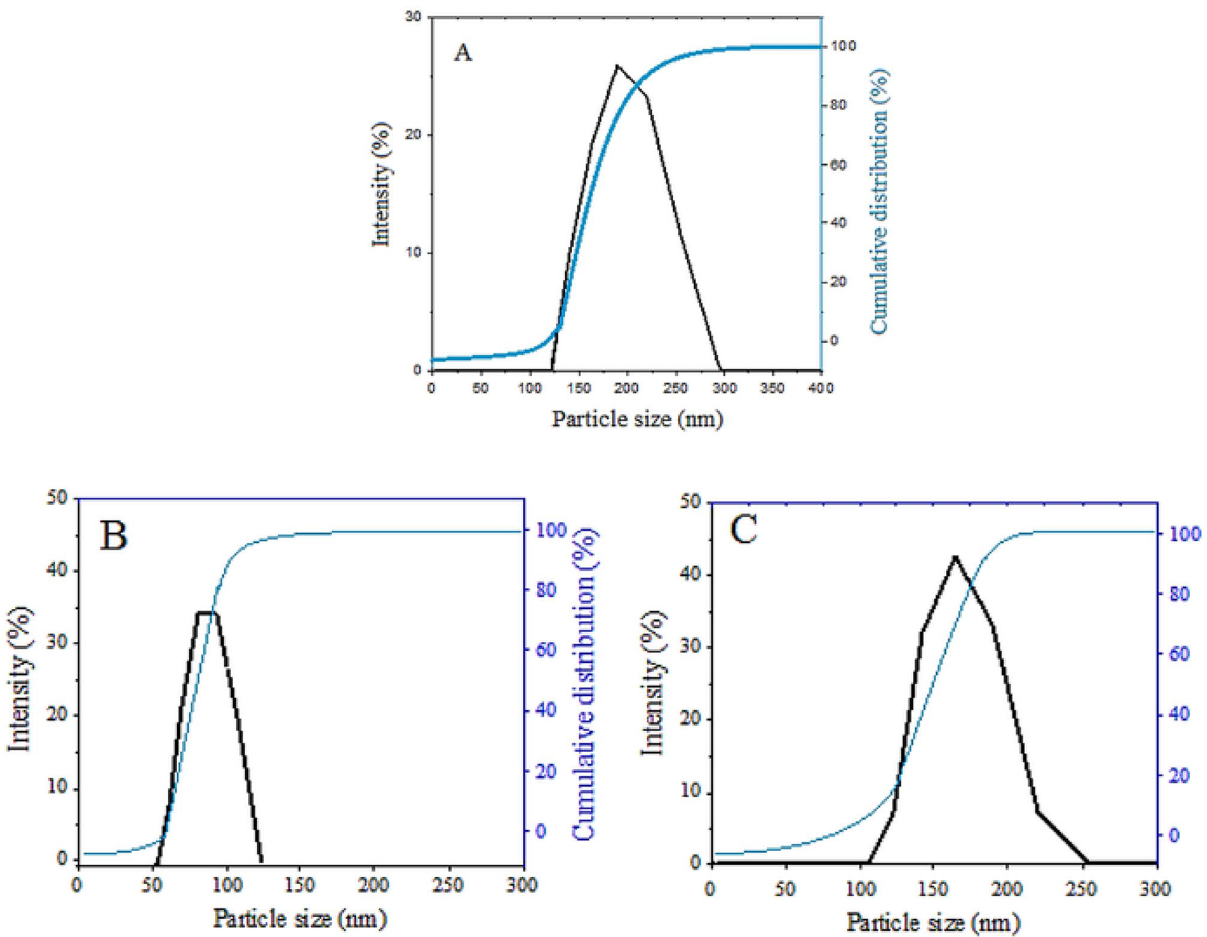
Figure 7. Cumulative and particle size distribution of ( A ) the iron oxide nanoparticles; (B) core–shell nanoparticles (FPEGSO-MLDH) and (C) core–shell nanoparticles